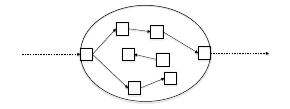
Figure 3: The basic structure of implemented models